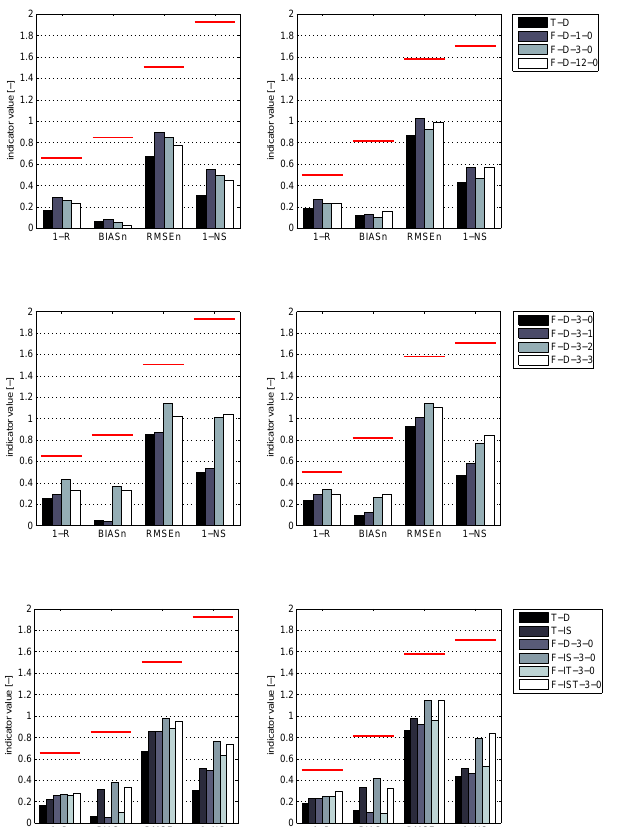
Fig. 7. Comparative bar charts of the assessment indicator values for the different calibration set-ups. Left panels: calibration period, right panels: validation period. The red lines show the average in- dicator values in case of random sampling the parameters in the confined parameter space, considered in this study.